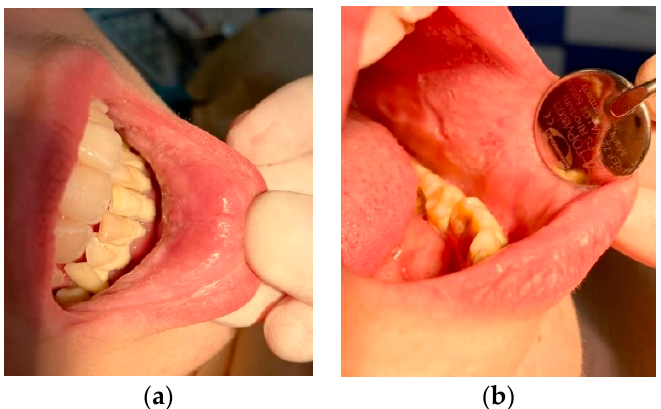
Figure 3. Chronic keratosis (Morsicatio buccarul) in a 16-year-old girl: ( a ) keratotic lesion on the oral mucosa of the inferior lip/plaque-induced gingivitis; ( b ) keratotic lesion on the oral mucosa of the left cheek.